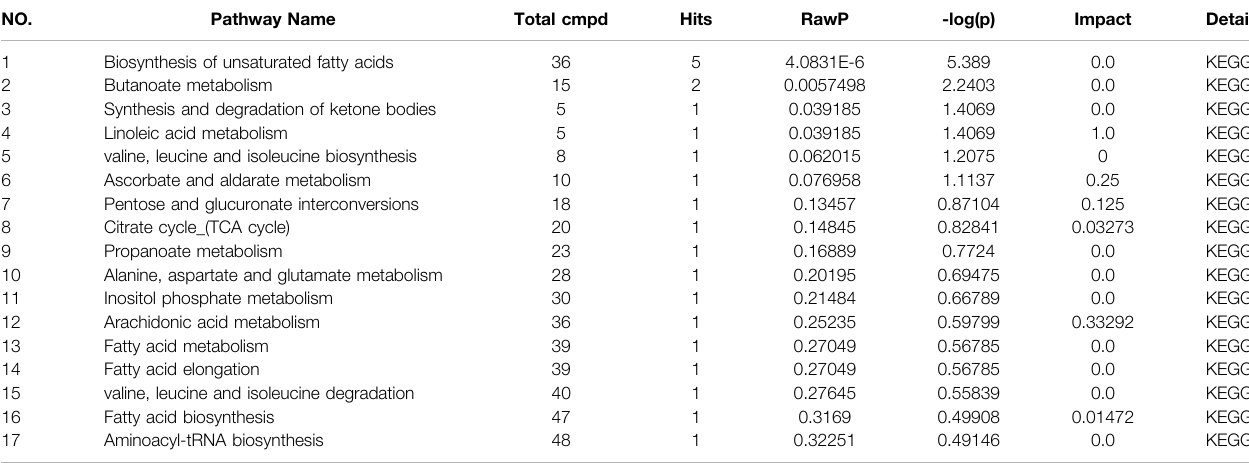
TABLE 3 | Metabolic pathway enrichment table of rat serum. NO.